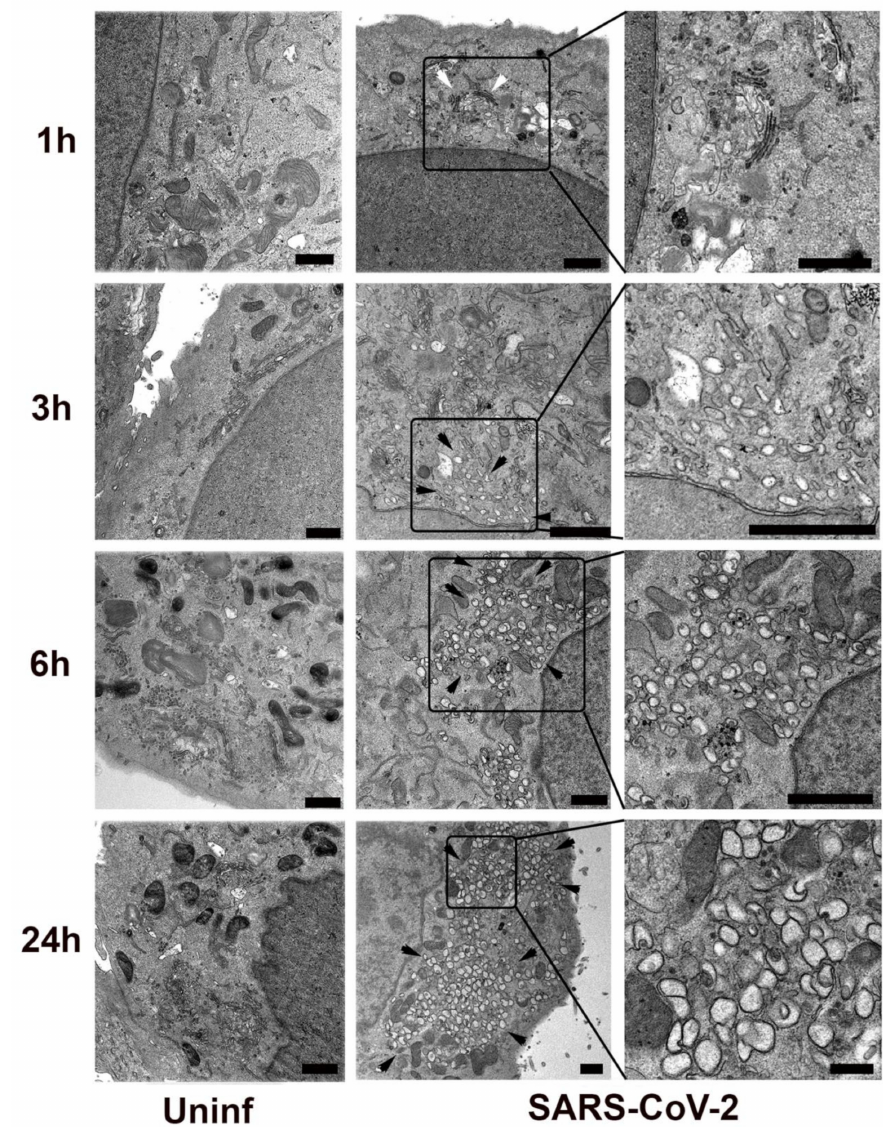
Figure 1. SARS-CoV-2 infected or mock-infected (Uninf) Vero E6 cells were fixed and processed for transmission electron microscopy at 1, 3, 6, or 24 h post-infection. Black arrowheads indicate regions enriched in SARS-CoV-2 induced membrane proliferation. White arrowhead indicates the intact Golgi apparatus in the 1 h sample. Delineated regions of interest in the infected cells are enlarged in the right column to show detail. Bars = 1 µ